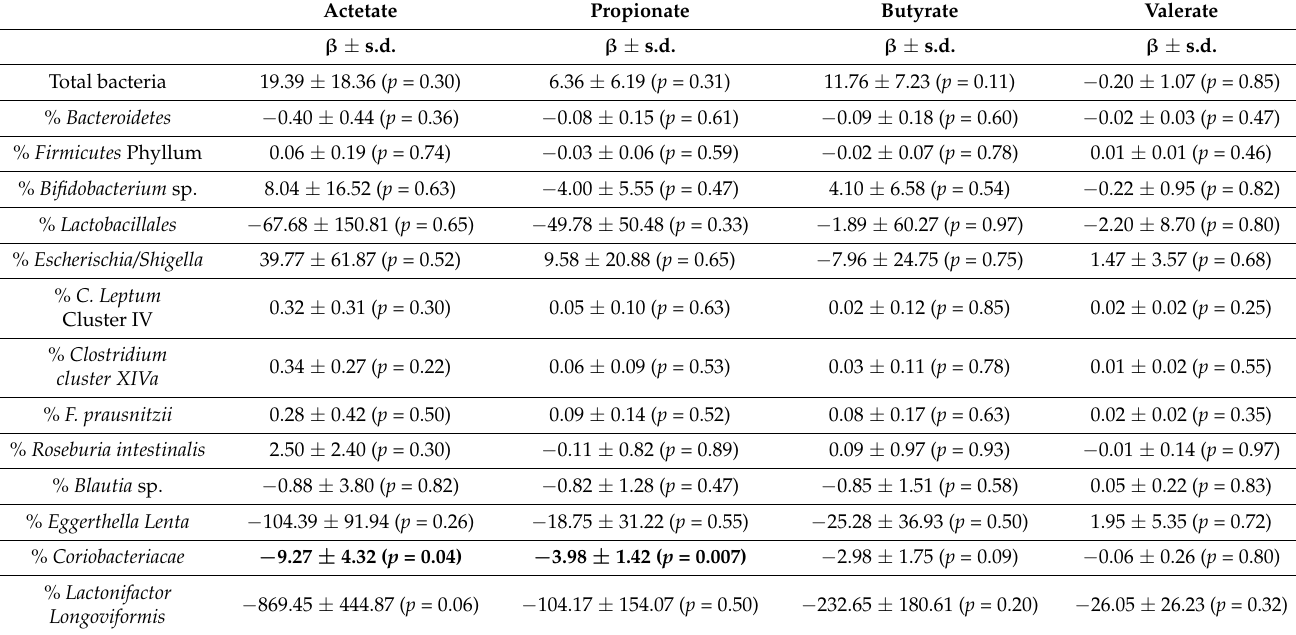
Table 7. Correlation between stool microbiota composition and short chain fatty acids in FW. Actetate